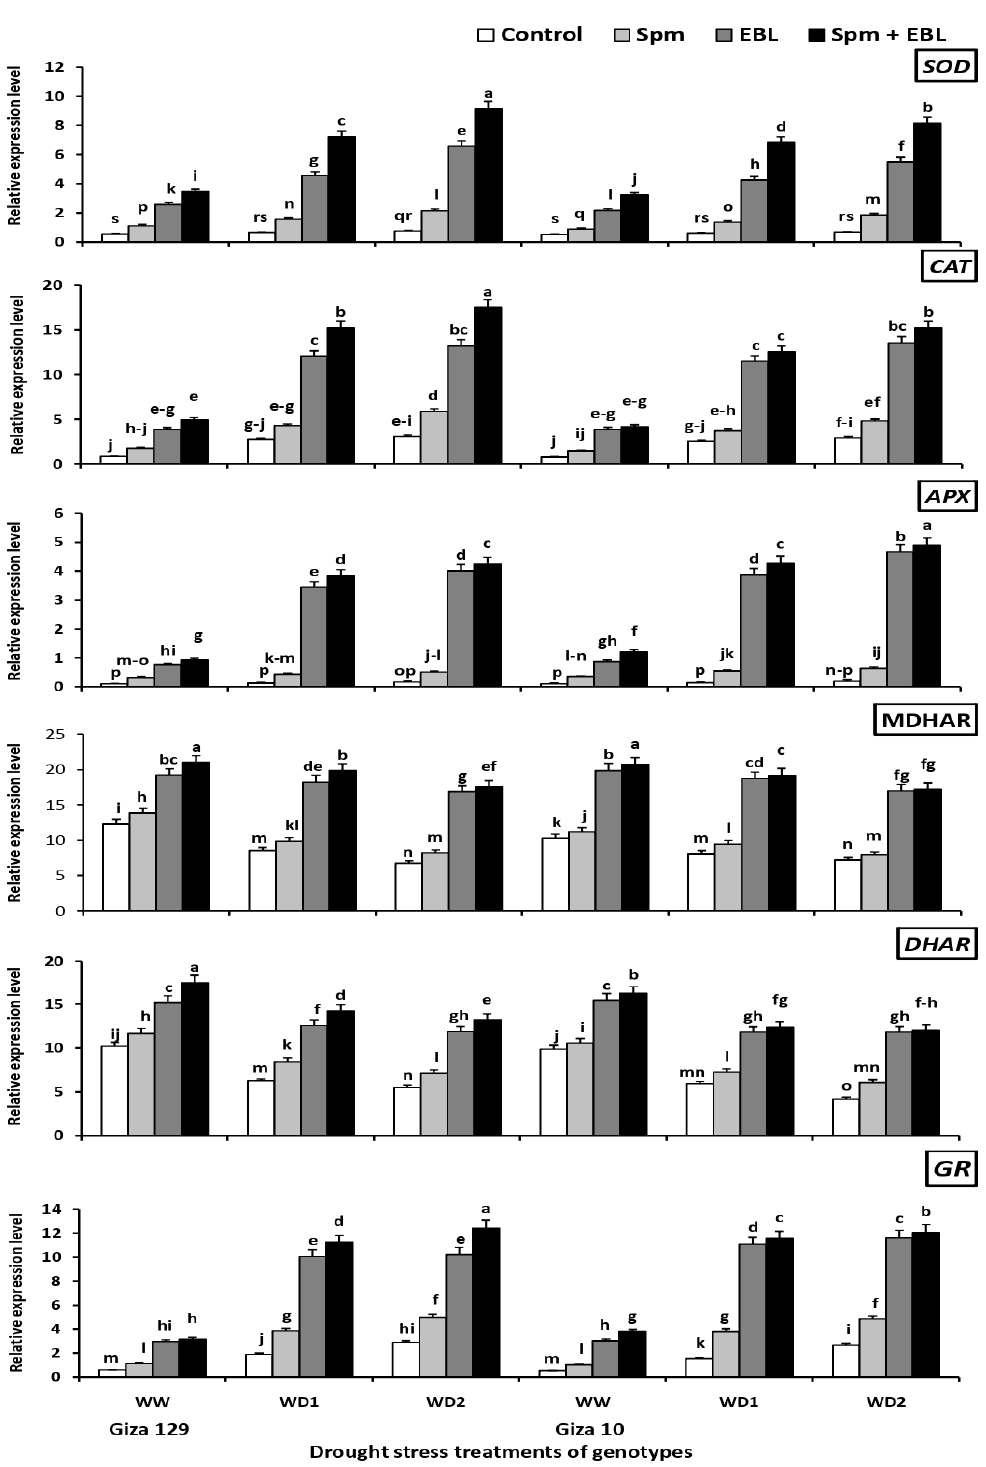
Figure 3. Relative levels of expression of ZmSOD , superoxide dismutase; ZmCAT , catalase; ZmAPX , ascorbate peroxidase; ZmMDHAR ,monodehydroascorbate reductase; ZmDHAR , dehydroascorbate reductase; and ZmGR , glutathione reductase genes, compared with the ubiquitin carrier protein ( ZmUBCP ) gene were analyzed in leaves of maize plants after seven days of foliar application with distilled water (control), 25 mg L − 1 Spm, 0.1 mg L − 1 EBL, or 25 mg L − 1 Spm + 0.1 mg L − 1 EBL to both genotypes—Giza 129 and Giza 10—exposed to drought stress treatments (control (100% field capacity (FC); WW) and water deficit (75% FC and 50% FC; WD1 and WD2)). Values are the mean ± SE (n = 6). Different letters indicate significant differences at p < 0.05 level according to LSD